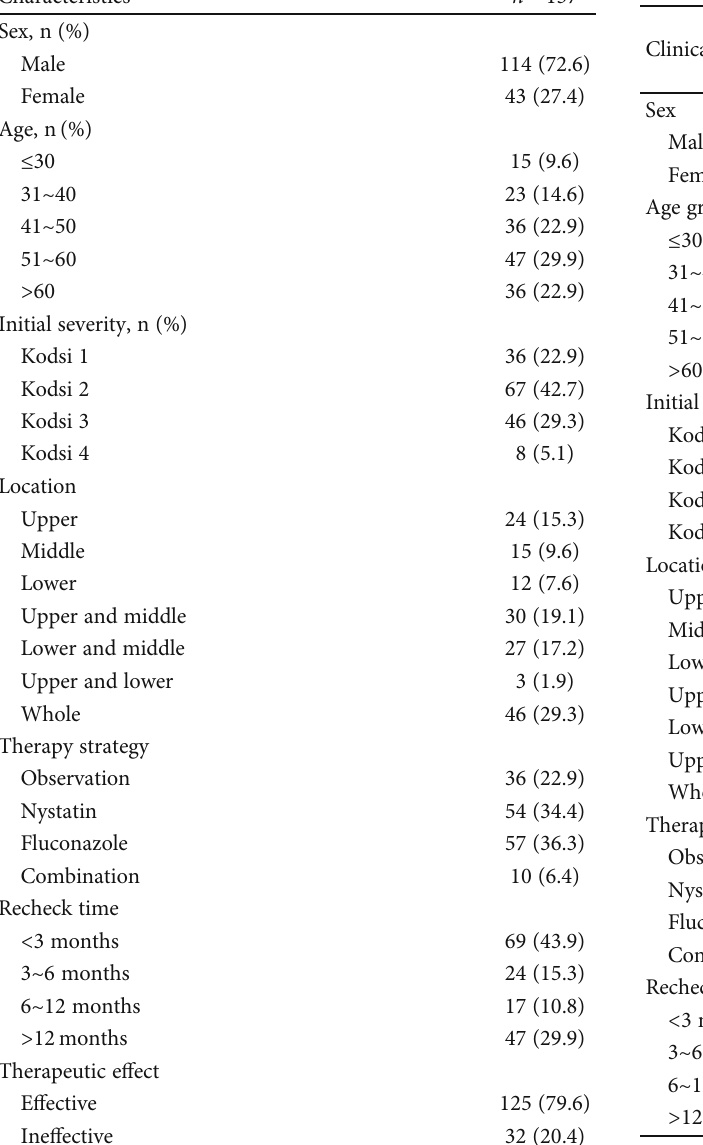
Table 4: Characteristics of the therapeutic cases. Table 5: Comparison of the clinical characteristics between the e ff ective and ine ff ective